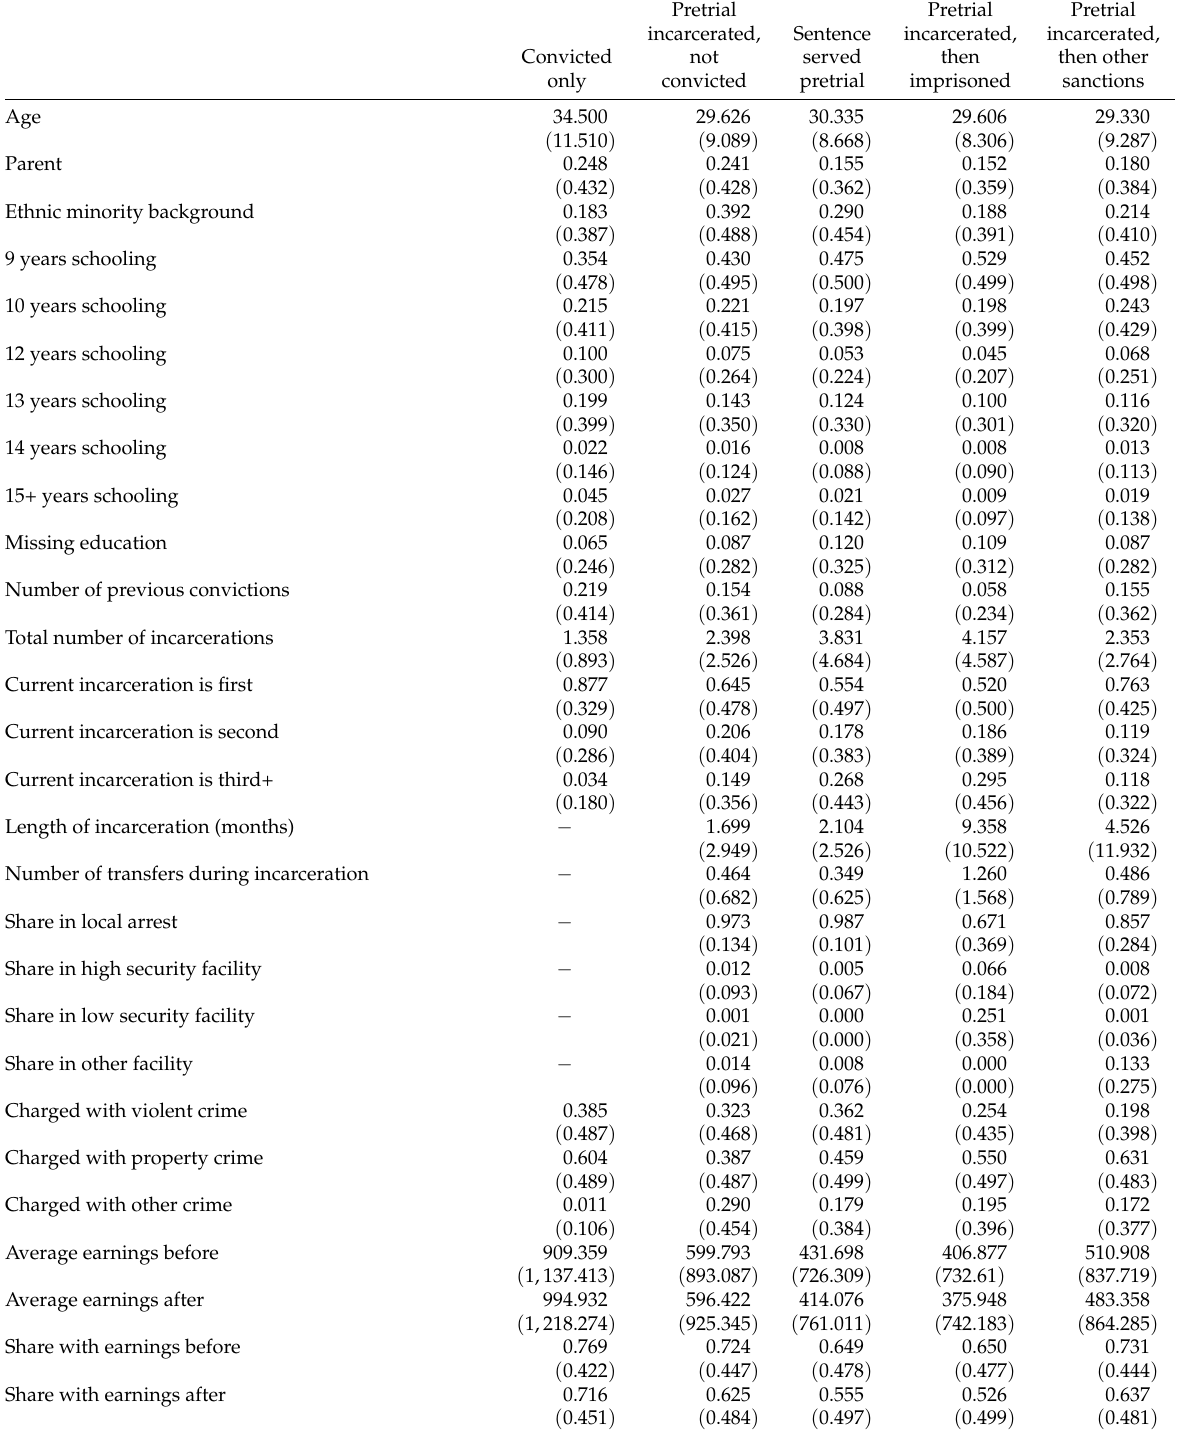
Table 1: Descriptive statistics of analytic sample, by sanction status. Men, Denmark, 1995 to